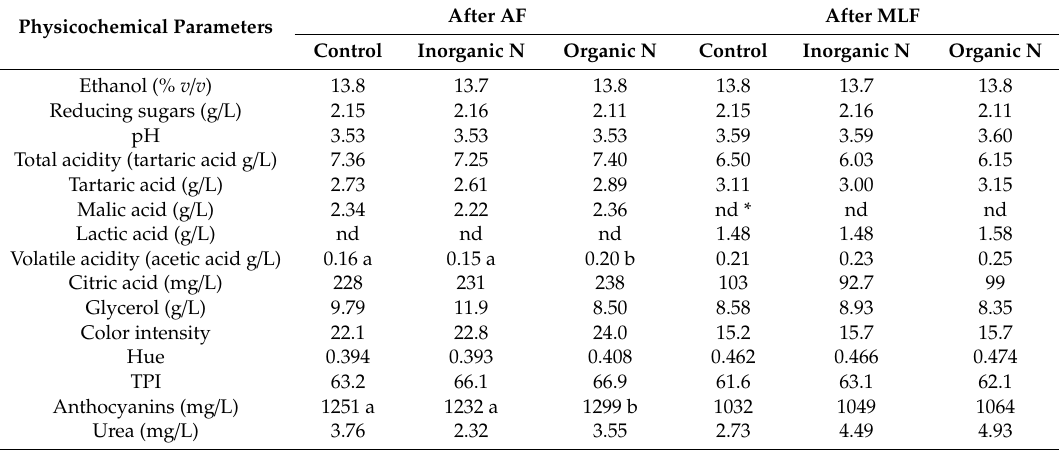
Table 1. Average values of physicochemical parameters of the wines after alcoholic fermentation (AF) and MLF with di ff erent nitrogen